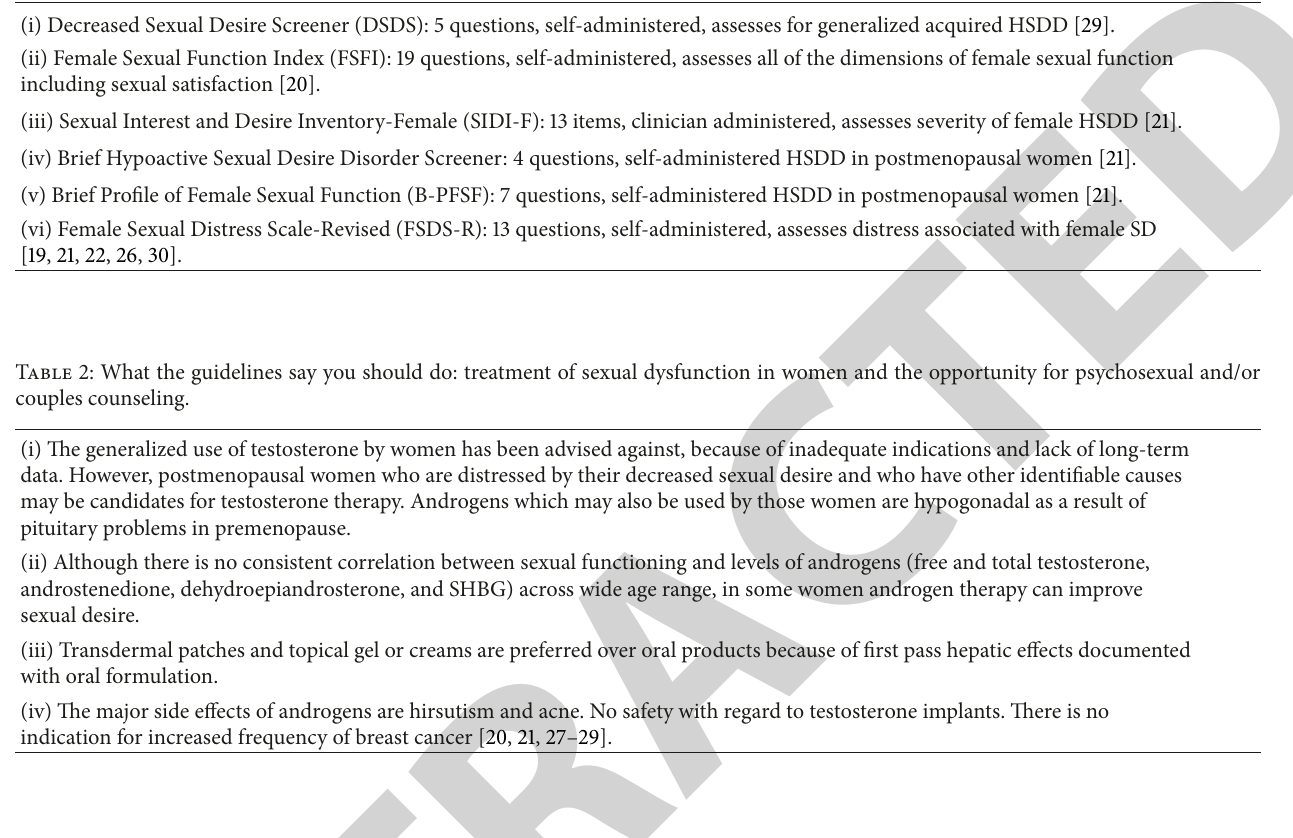
Table 1: Screening tools for FSD.